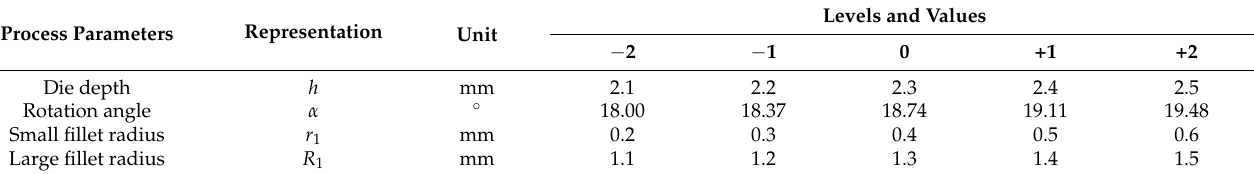
Levels and Values